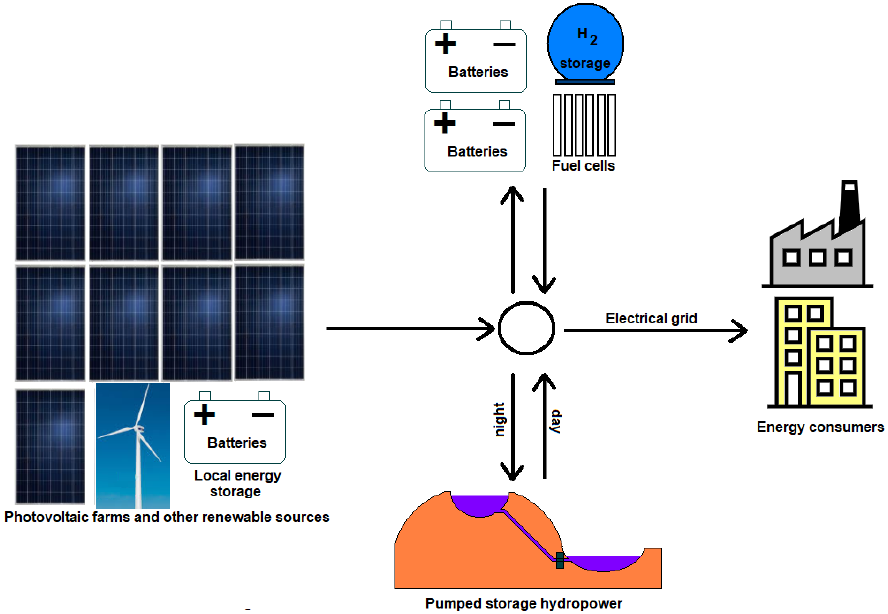
Figure 6. Structure of the proposed electrical energy system based almost exclusively on photovoltaics, own elaboration.